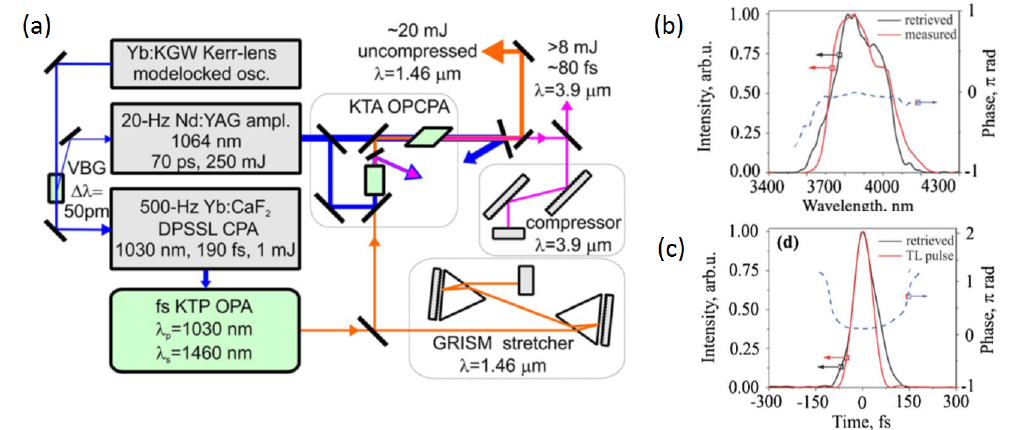
Figure 7. ( a ) Scheme of the OPCPA set-up for pulses amplification at 3.9 µ m; ( b ) measured (red) and retrieved spectral intensity (black) and phase (dashed); ( c ) temporal intensity profile corresponding to a pulse duration of 83 fs. Adapted with permission from [45], Copyright OSA Publishing, 2011. The Yb:Ca F 2 amplifier is used for pumping a white-light-seeded KTP-based OPA at the repetition rate of 0.5 kHz. As an output from the OPA, a signal is produced at 1.46 µ m with an energy of 65 µ J; the phase-stable idler beam at 3.9 µ m is discarded. The signal pulses are then stretched into a Grating-prism (GRISM)